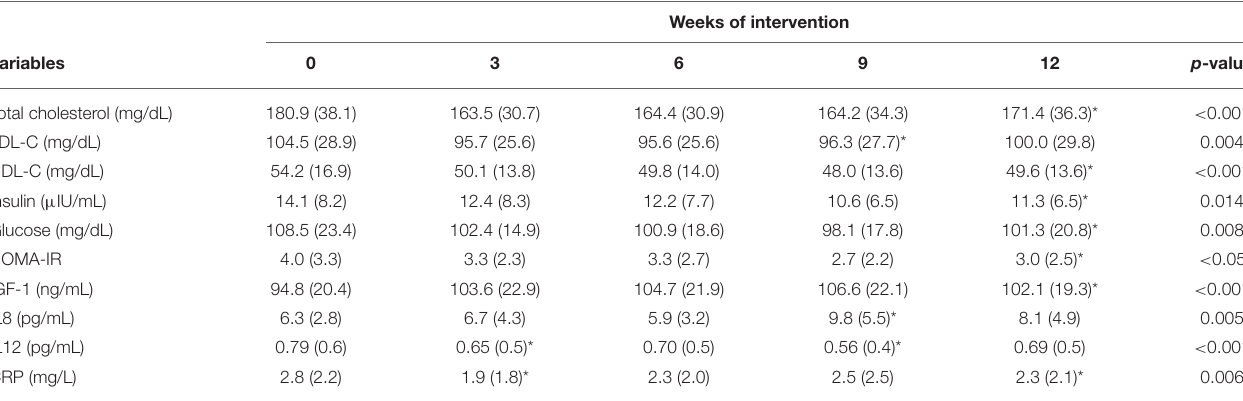
TABLE 4 | Cardiometabolic biomarker changes in obese older adults consuming the DASH diet for